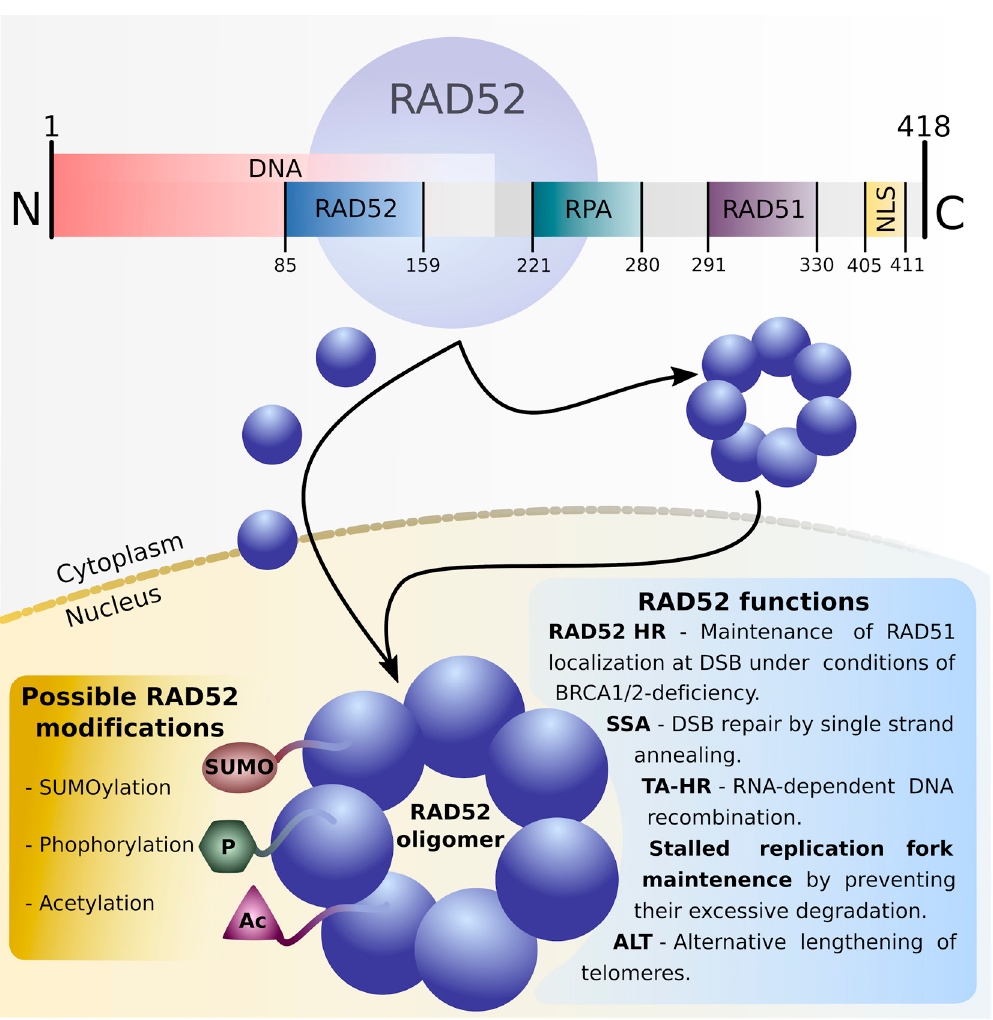
Figure 2. Human RAD52 structure, post-translational modifications, and functions. N-terminal fragment of RAD52 contains a region responsible for its oligomerization and binding with DNA molecule. C-terminal area includes domains interacting with replication protein A (RPA) and RAD51 recombinase, as well as nuclear localization signal (NLS) region responsible for RAD52 transportation to the nucleus. According to the “nuclear retention model”, RAD52 monomer possesses a weak NLS signal allowing only slow transport to the nucleus where RAD52 undergoes oligomerization. The “additive NLS model” suggests formation of RAD52 ring in the cytoplasm, resulting in an additive NLS effect and more robust RAD52 ring transportation to the nucleus. Activity of RAD52 and its participation in different recombination processes can be modulated by post-translational modifications including SUMOylation, phosphorylation, and acetylation.